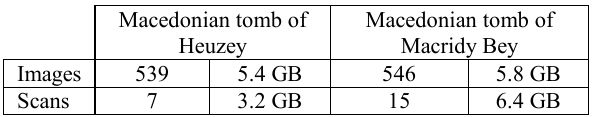
Table 1: Data collected for the 3D